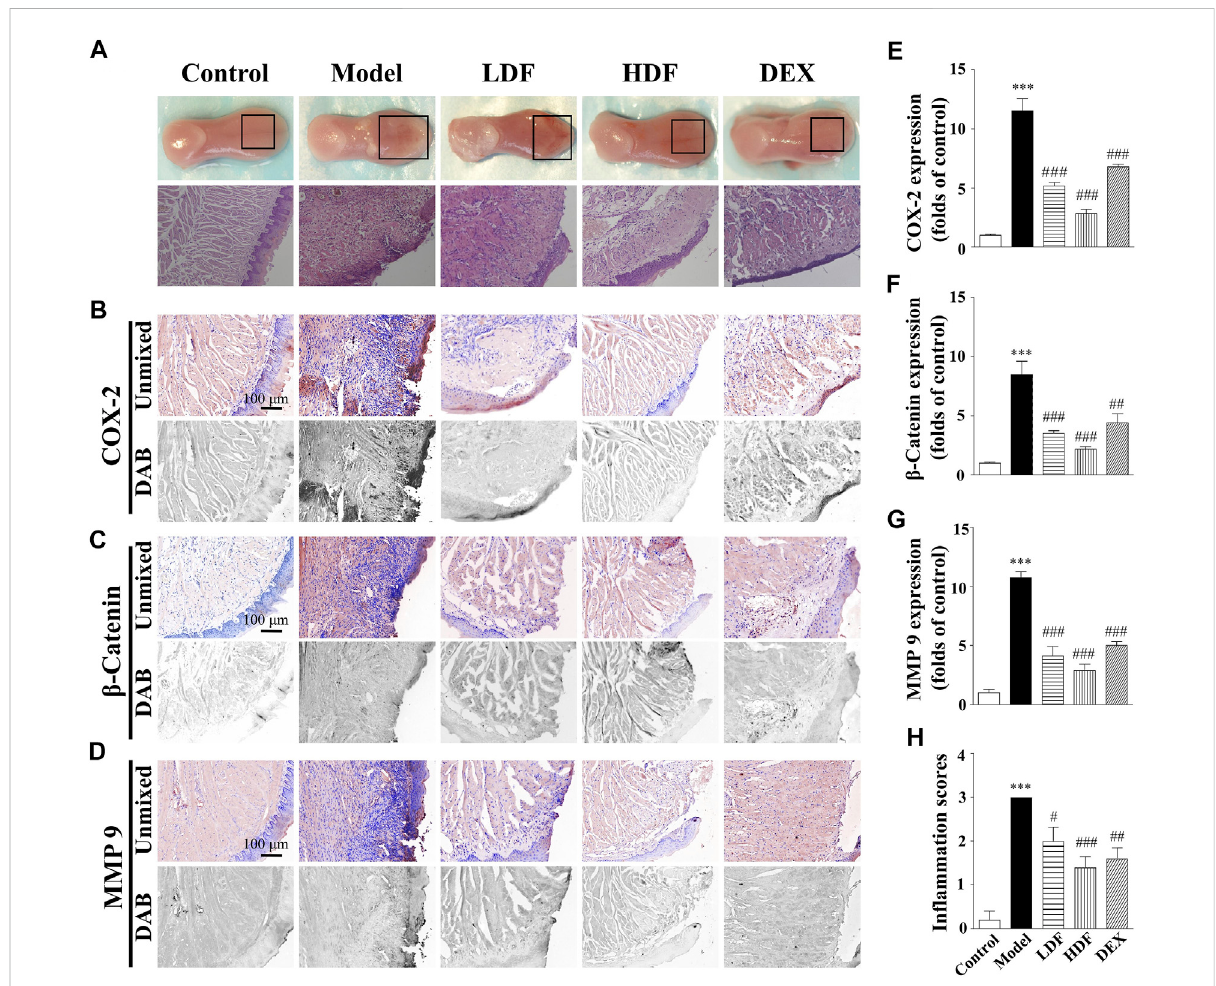
FIGURE 4 Wound healing acceleration of Frankincense for sodium hydroxide-caused oral burns in mice. (A) General view of the tongue samples, and H&E;staining of tongue sections in control, model, Frankincense (LDF and HDF are denoted low- and high-dose groups, respectively), and dexamethasone (DEX) groups, respectively. Representative (B – D) and summary (E – G) of histochemistry analysis of expression of COX-2, β -catenin andMMP-9,respectively (H) Thein fl ammationscoresofthetonguesamplesintheH&E-stainedimages.Scalebar,100 µm.Comparedwiththe control group, ppp , p < 0.001. Compared with the model group, #, p < 0.05, ##, p < 0.01, ###, p <